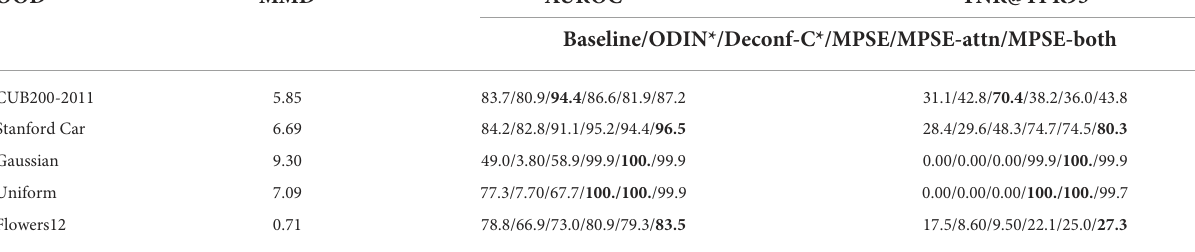
TABLE 7 Performance of different methods on large size image data (Flowers90). OOD MMD AUROC